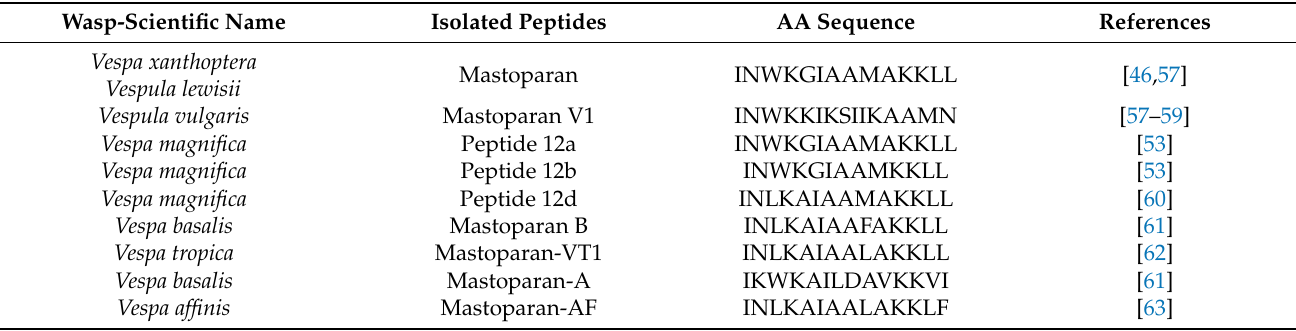
Table 3. Representative Mastoparans from